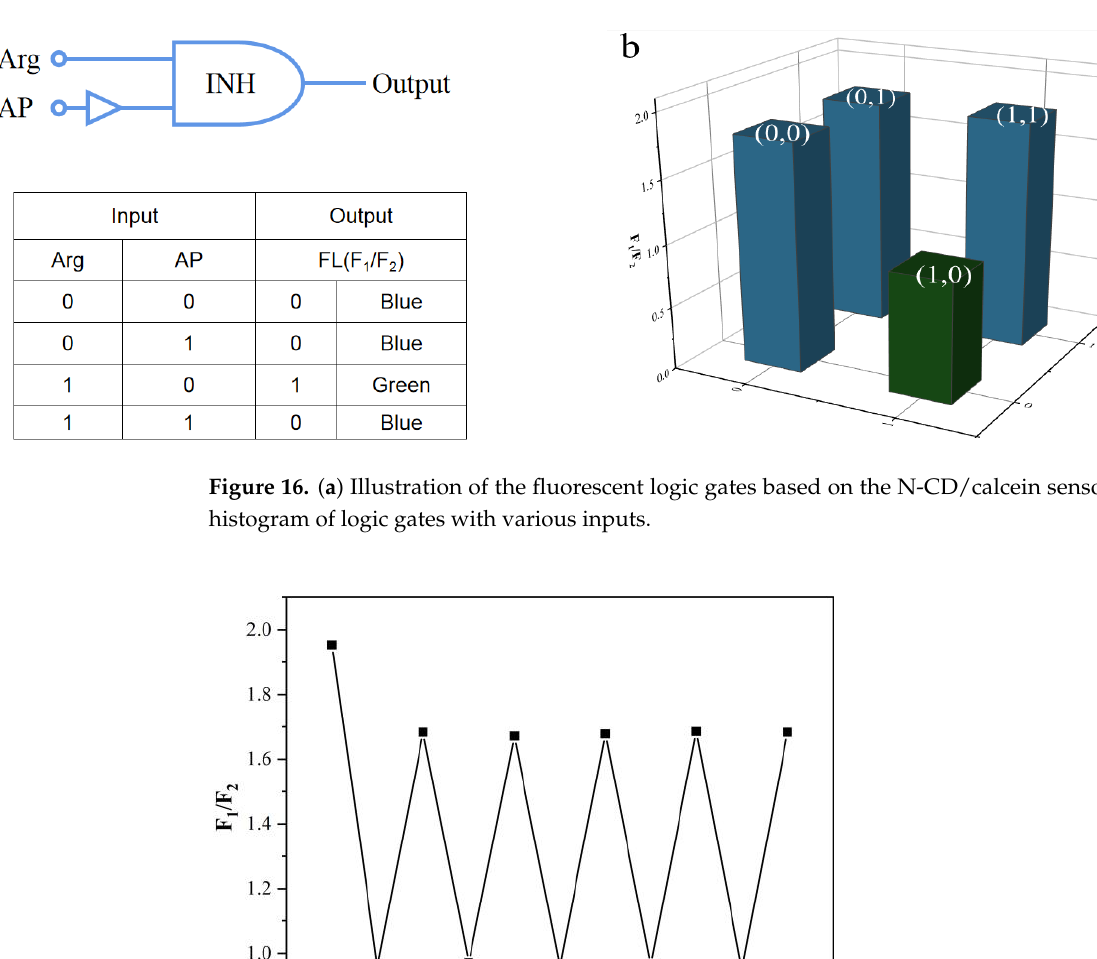
Figure 17. F 1 /F 2 ratio of N-CD/calcein sensor with sequential addition of Arg and AP.